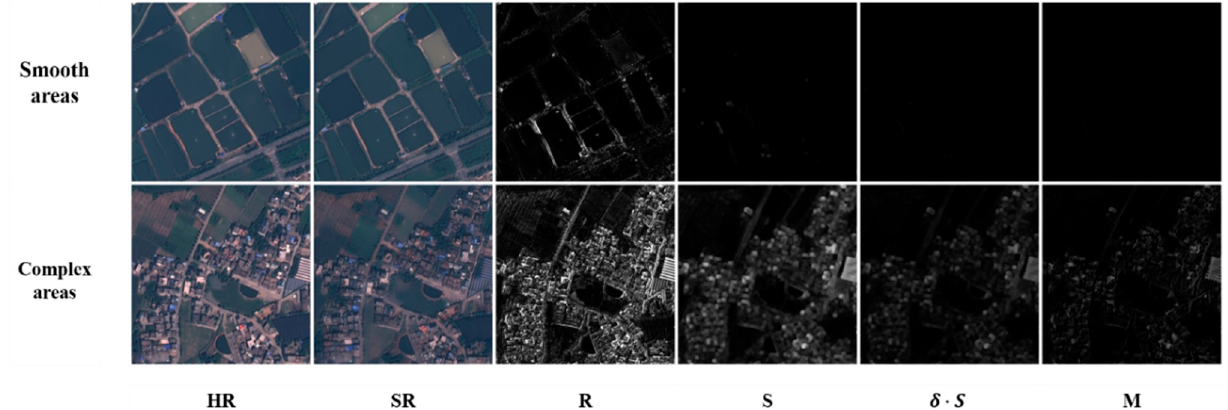
Figure 1. Framework of the method. For the LR input, the reconstruction is performed by a GAN network containing second-order channel attention and region-level non-local blocks; region-aware loss is used to constrain the generation of artifacts.